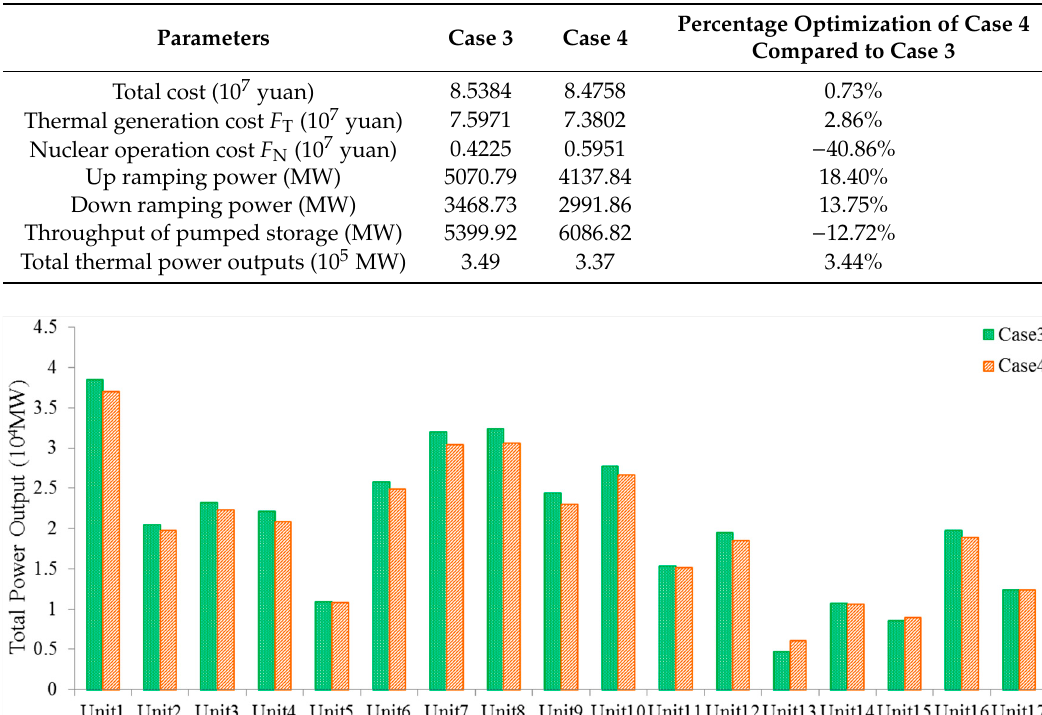
Table 4. Result comparison of Case 2 and Case 4 in a day.